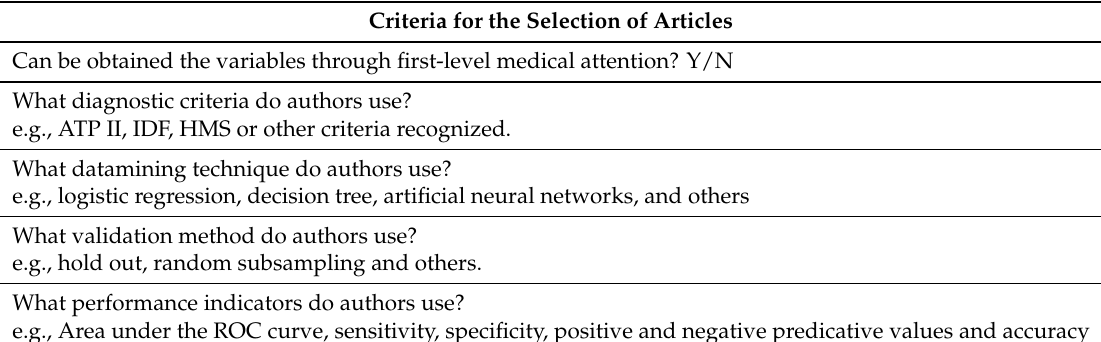
Table 2. Criteria established for choosing the articles. Criteria for the Selection of